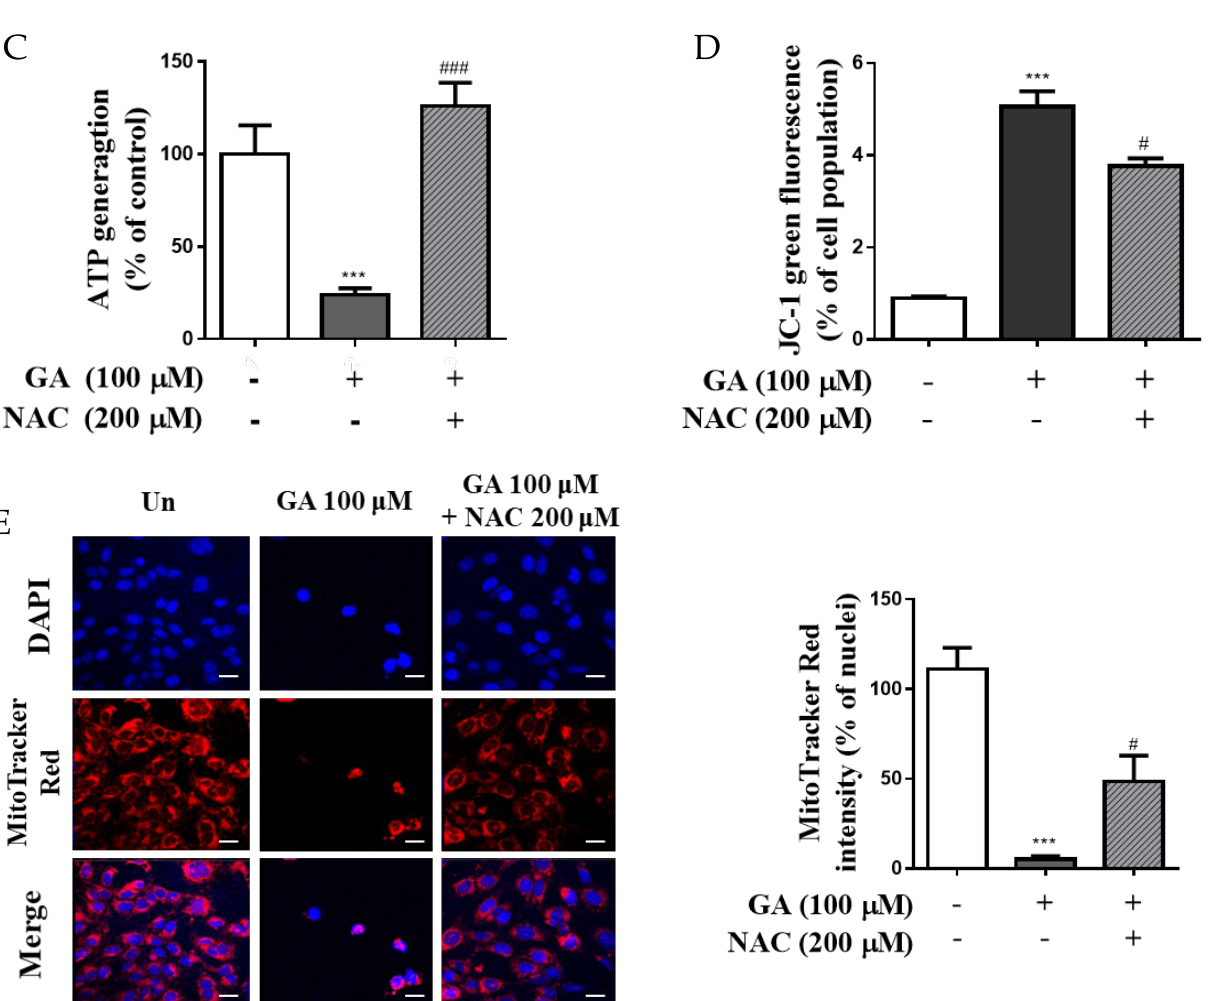
Figure 5. GA-stimulated apoptosis through the oxidative stress via mitochondrial dysfunction in mesangial cells. Cells were incubated with GA (100 μM) and GA cotreated with NAC (200 μM) for 24 h. ( A ) The rate of apoptosis induced by GA in mesangial cells and the rate of apoptotic cells are presented as percentage of apoptotic cells per total cell number. ( B ) TUNEL staining images are shown, where red fluorescence indicates DNA fragmentation. Apoptosis was stimulated by GA and prevented by ROS induction via NAC cotreatment (DAPI blue = nuclei) (scale bar = 10 μm). The bar graph shows the percentage of TUNEL-positive nuclei relative to the control, measured using Im- ageJ software. ( C ) The levels of ATP production were measured using a bioluminescence ATP de- tection assay kit. ( D ) MMP was determined using JC-1 dye by flow cytometry. ( E ) Images were visualized by confocal microscopy through double-staining with MitoTracker Red and DAPI. Red and blue fluorescence represent MitoTracker Red-stained mitochondria and nucleus, respectively (scale bar = 10 μm). The graph shows the percentage of fluorescence intensity relative to the control, measured using ImageJ software. Data are expressed as mean ± SD. Independent experiments were performed at least thrice. * p < 0.05, ** p < 0.01, and *** p < 0.001 vs. untreated group, and # p < 0.05, ## p < 0.01, and ### p < 0.001 vs. 100 μM GA. GA, glycolaldehyde; NAC, N-acetyl-l-cysteine.